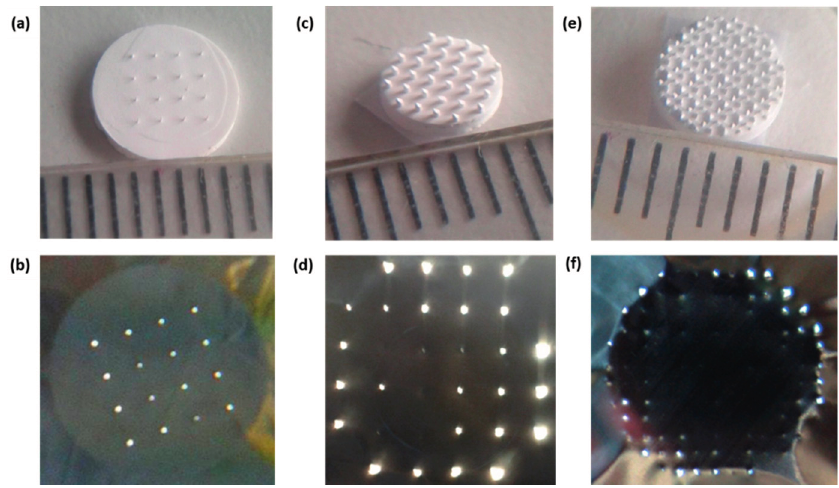
Figure 10. Overview images and corresponding back-light images of 3 different types of npMNA on foam as a skin model. ( a , b ) SN-4x4-R100; ( c , d ) SN-fc-D300; ( e , f )